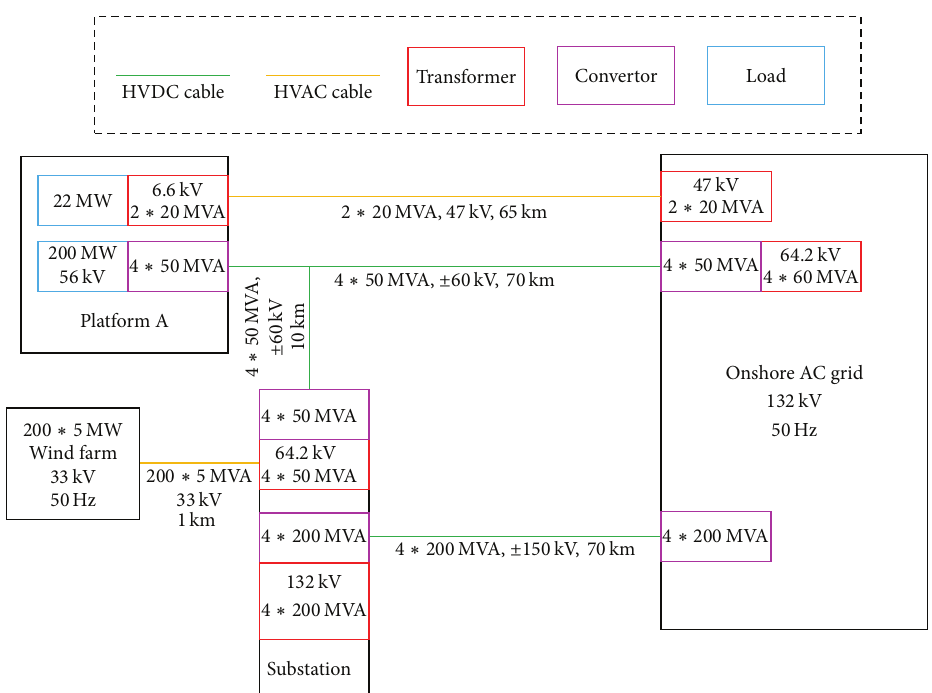
Figure 11: Frequency, voltage, and power variations due to the loss of wind power.